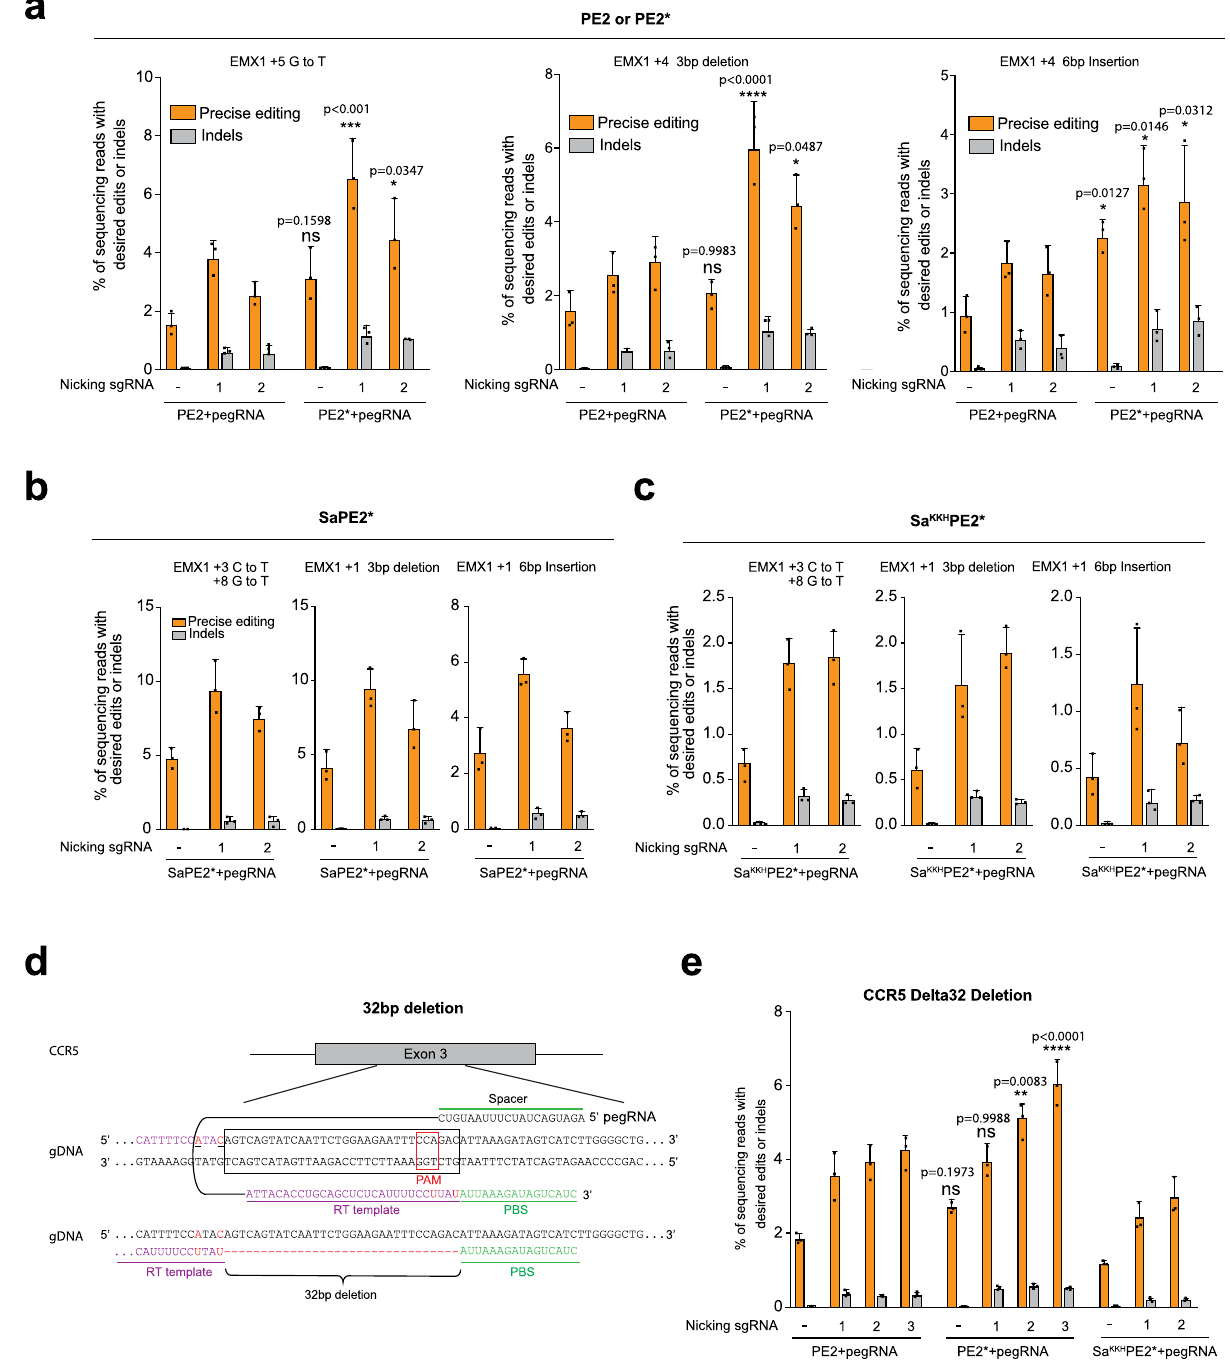
Fig. 2 Improved PE2* increases editing ef fi ciency at endogenous loci. a Comparison of editing ef fi ciency for nucleotide substitution, targeted 3-bp deletion, and 6-bp insertion with PE2 and PE2* at EMX1 locus in HEK293T cells. Indels broadly indicate mutations to the endogenous sequence that do not result in the desired sequence alteration. b – c Editing ef fi ciency for nucleotide substitution, targeted 3-bp deletion, and 6-bp insertion with SaPE2* ( b ) and Sa KKH PE2* ( c ) at EMX1 locus in HEK293T cells. d Sequence of CCR5 locus and pegRNA used for the 32 bp deletion. Two mutations in red were included to demonstrate that sequence collapse was not a function of nuclease-induced microhomology-mediated deletion and to reduce re-cutting of deletion allele. The bottom panel shows the alignment of pegRNA with the CCR5 sense strand. e Comparison of ef fi ciency for generating a targeted 32-bp deletion with PE2, PE2*, and Sa KKH PE2* within CCR5 in HeLa cells. All expression vectors were delivered by transient transfection. The presence of sgRNAs to promote nicking of the complementary strand is indicated in each fi gure panel. Results were obtained from three independent experiments and presented as mean ± SD. *P < 0.05, **P < 0.01, * **P < 0.001, * ***P < 0.0001 by one-way ANOVA with Tukey ’ s multiple comparisons test. ns, not signi fi cant.